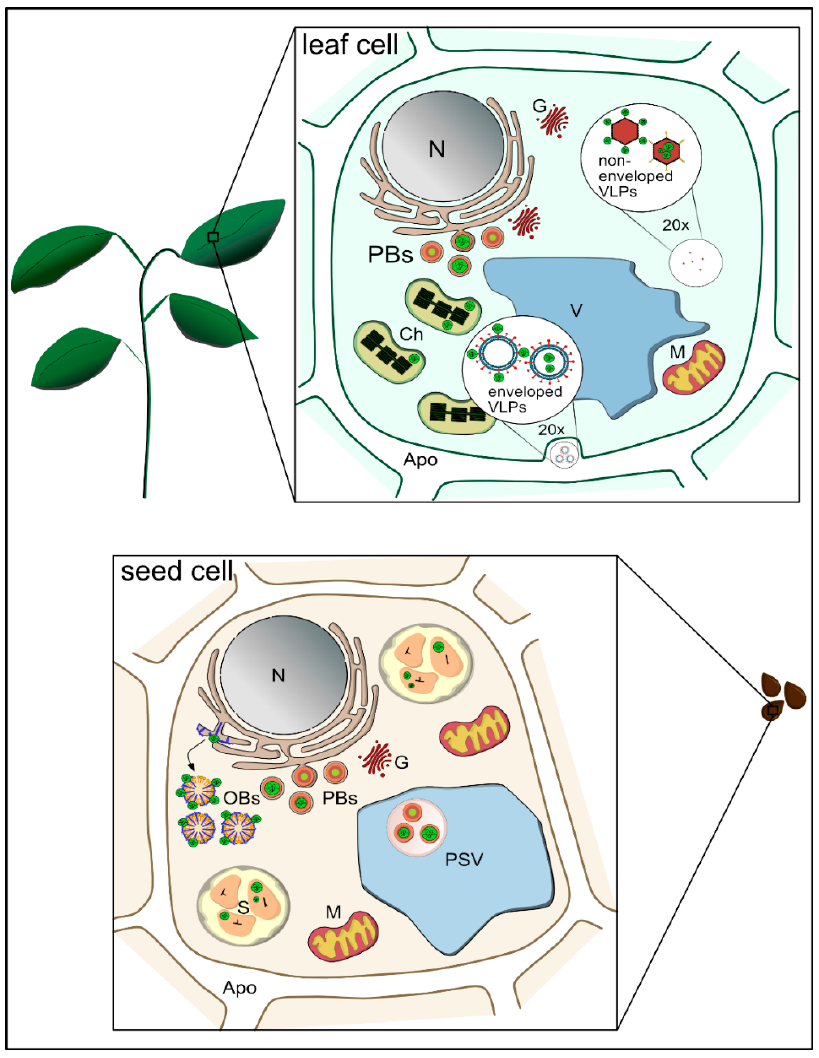
Figure 2 . Plant-produced micro- and nanoparticles can be used to incorporate recombinant proteins (green circles). Specialized tissues in seeds (lower panel) are characterized by the presence of starch granules (S), oil bodies (OBs) or protein bodies (PBs), which may also be sequestrated into the protein storage vacuole (PSV). In leaves (upper panel), the formation of recombinant PBs can be induced ectopically, and plastid transformation enables the expression and accumulation of recombinant proteins in chloroplasts (Ch). In addition, nanoparticles such as enveloped and non-enveloped virus-like particles (VLPs) can be produced in planta. Recombinant proteins (green circles) may be incorporated into PBs or starch granules, associated to the surface of OBs, or they may be enclosed within or displayed on VLPs. N…Nucleus, V…Vacuole, G… Golgi, Apo… Apo- plast.